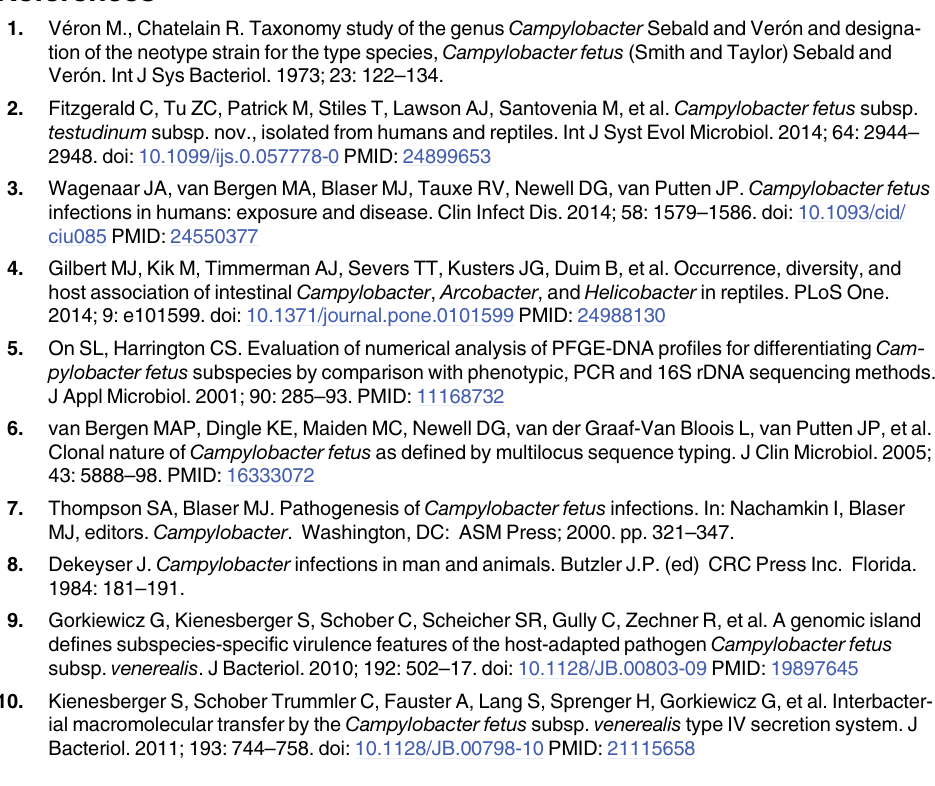
S1 Fig. Phylogenetic analysis of Fic-encoding sequences. The scale bar represents the mean number of nucleotide substitutions per site. (TIF) S2 Fig. BRIG alignment of chromosomally-located T4SS regions 1A, 1E and 2A, and fic genes. Shown are the locations of the chromosomal T4SS regions 1A, 1E and 2A in the refer- ence genomes, using strain 84 – 112 or strain 01/165 as reference. Strain 04/554 is used as refer- ence to show the location of a genomic island with four fic- encoding sequences. (TIF) S1 Table. Genome positions of fic encodinggenes.